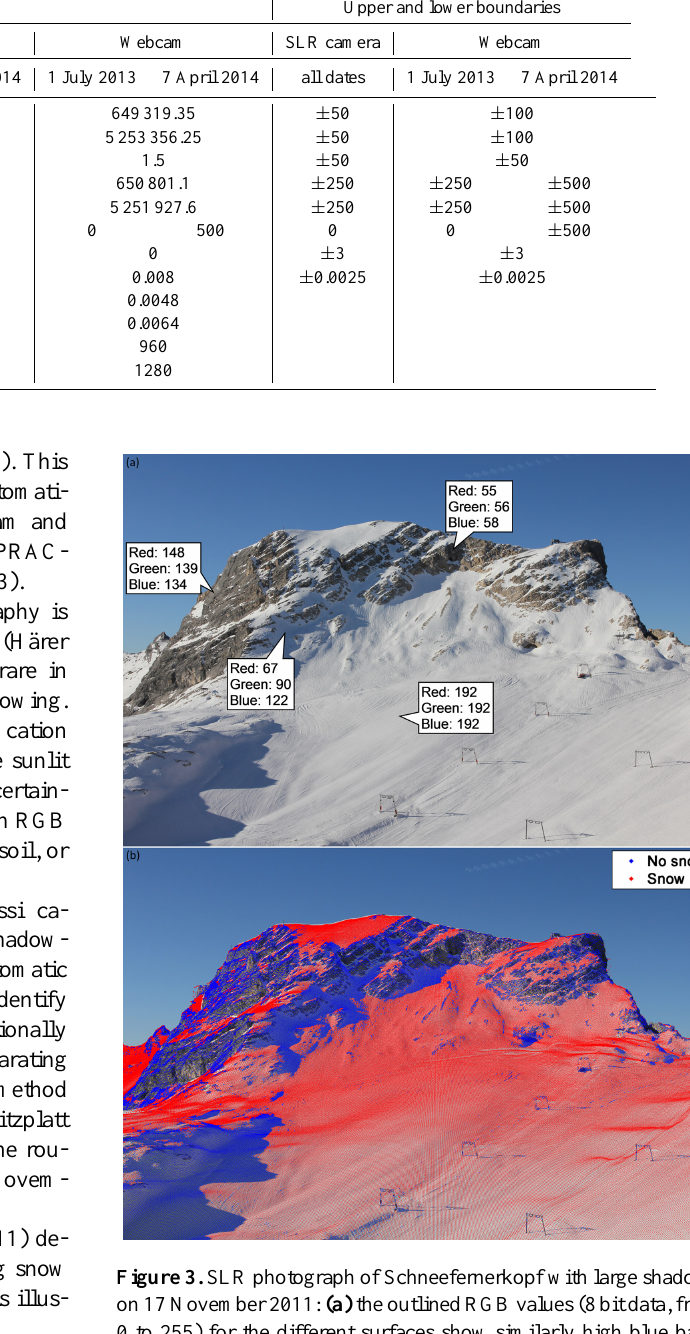
Table 1. Estimated parameters of the exterior and interior camera orientation of the SLR and webcam before the optimization: the parameter ranges in the optimization for the cameras and dates are given as differences in m except noted otherwise to the estimated values. For the webcam photograph on 7 April 2014, the camera is directed towards an area outside of the DEM. Hence, the optimization of the camera target point offset t and an enlarged parameter range for the camera target point ( T t ) is necessary. Parameter Input Upper and lower boundaries